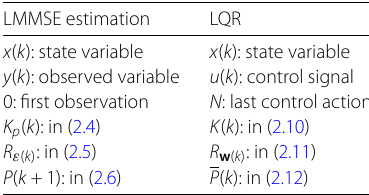
Table 1 Duality between estimation and control LMMSE